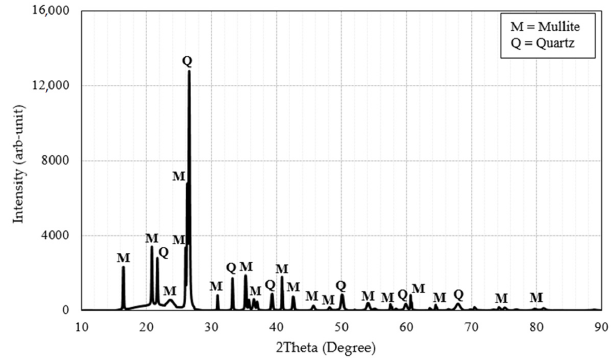
Figure 3. XRD diffraction pattern of fly ash calcined at 800 °C for 2 h (XRD: X ‐ ray diffraction).